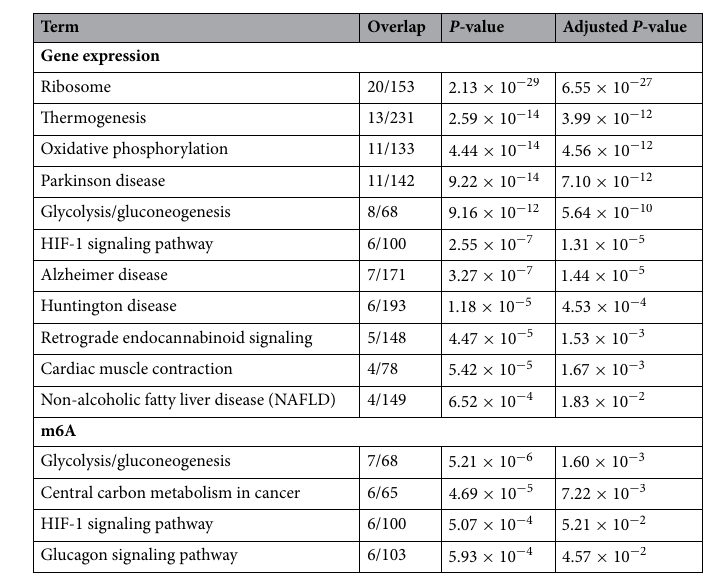
Table 6. “KEGG 2019 Human” category of Enrichr for 53 genes (based on gene expression) and 200 genes (based on m6A) selected by applying KTD-based unsupervised FE to integration of gene expression and m6A profile. Fifteen terms with adjusted P -values less than 0.05 are listed.